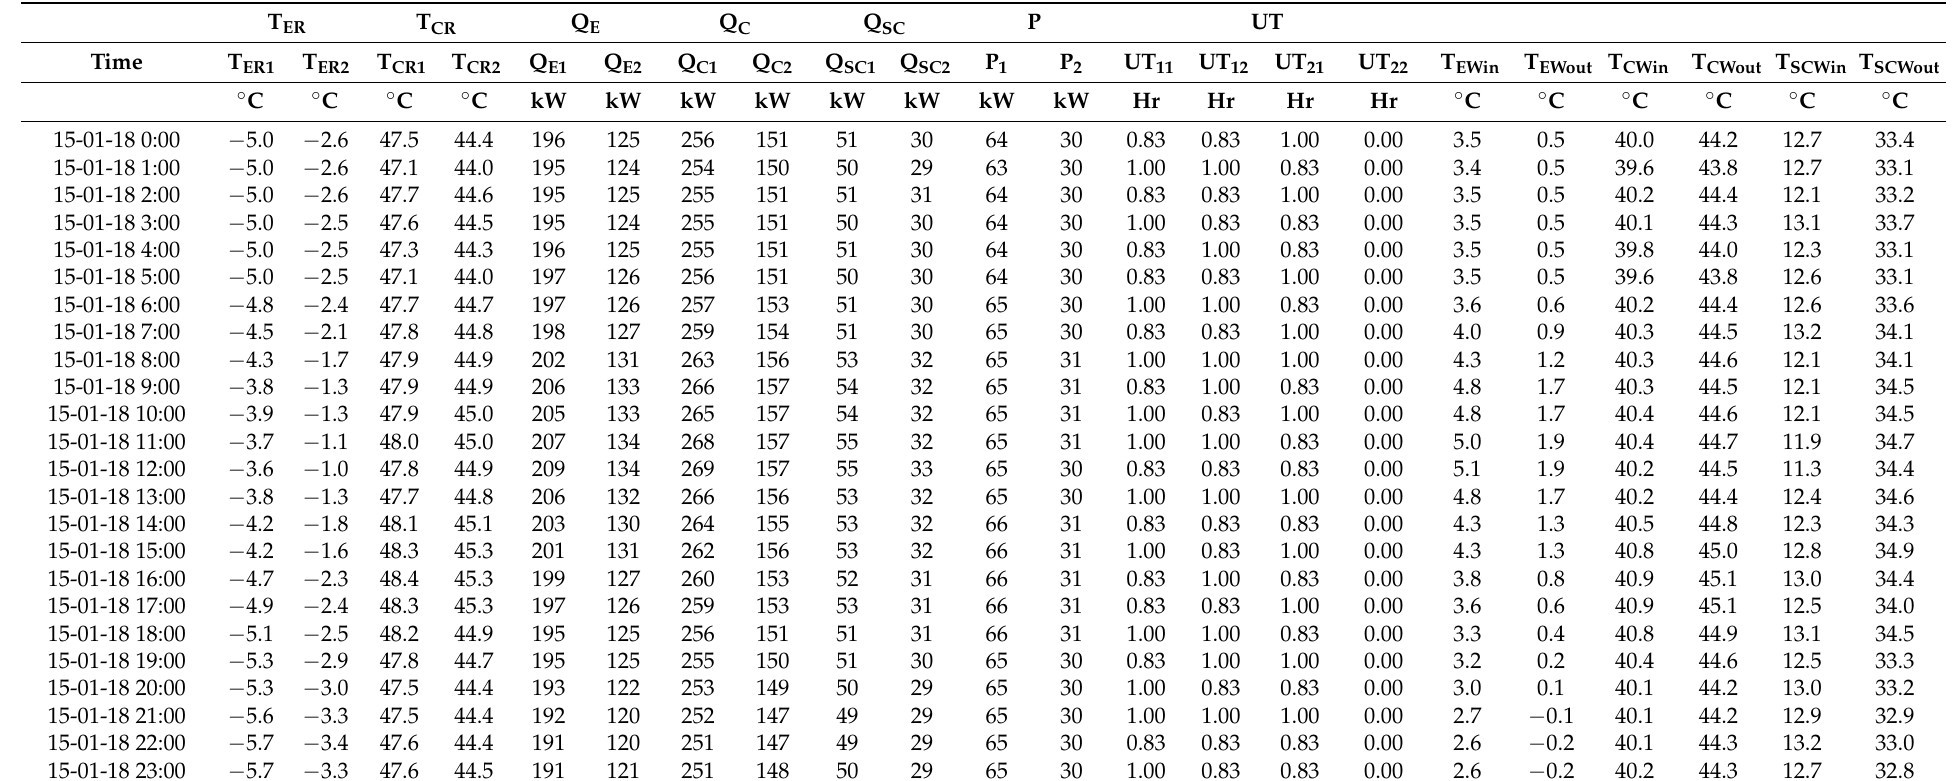
Table A2. Sample data from HP2 for a typical winter